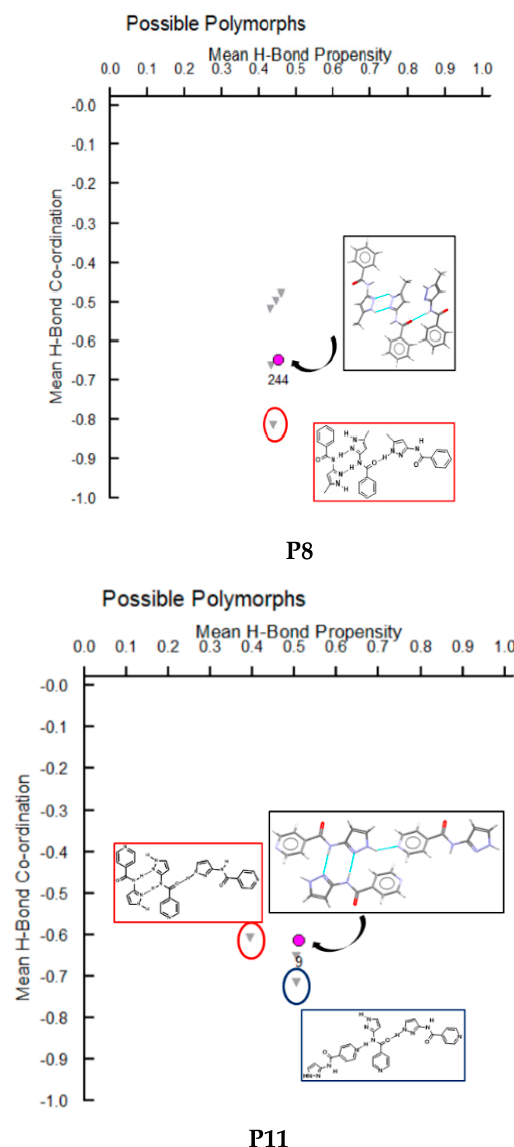
Figure 10. Synthon and packing observed in the crystal structure of P11 leading to 1-D chains along the crystallographic a -axis.